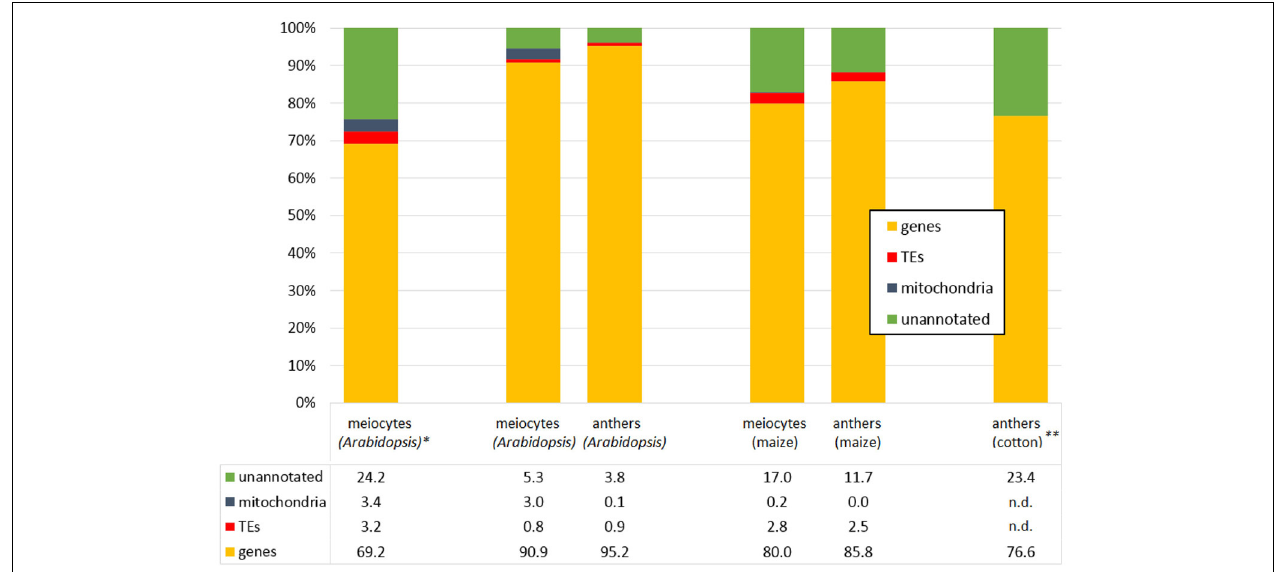
FIGURE 3 | Example distributions of aligned RNA-seq reads. Meiocyte or anther RNA-seq reads, mapping to genes, mitochondria sequence, transposable elements (TEs) and unannotated features. Data from Dukowic-Schulze et al. (2014a,b), ∗ Chen et al. (2010), ∗∗ Wei et al.